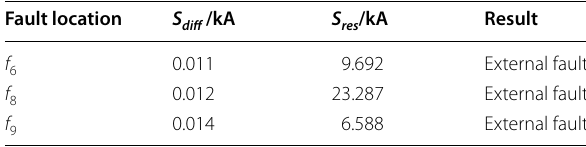
Table 4 Simulation results of N model when external faults occur